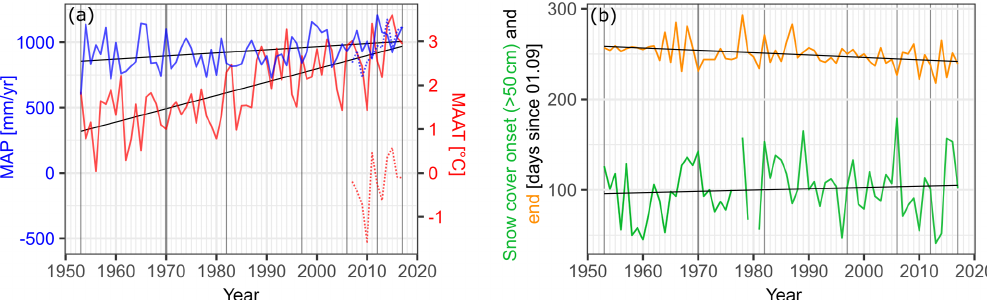
Figure 5. Changes in meteorological forcing during the study period between 1953 and 2017. (a) Mean annual precipitation (MAP) for the station Plangeroß (1605ma.s.l.) and mean annual air temperature (MAAT) for the station Obergurgl-Vent (1938ma.s.l.); the dashed lines indicate the values for the Weißsee station (2540m a.s.l.). (b) Snow cover onset and end for the station Obergurgl (1942ma.s.l.). The black lines show the trend of the respective